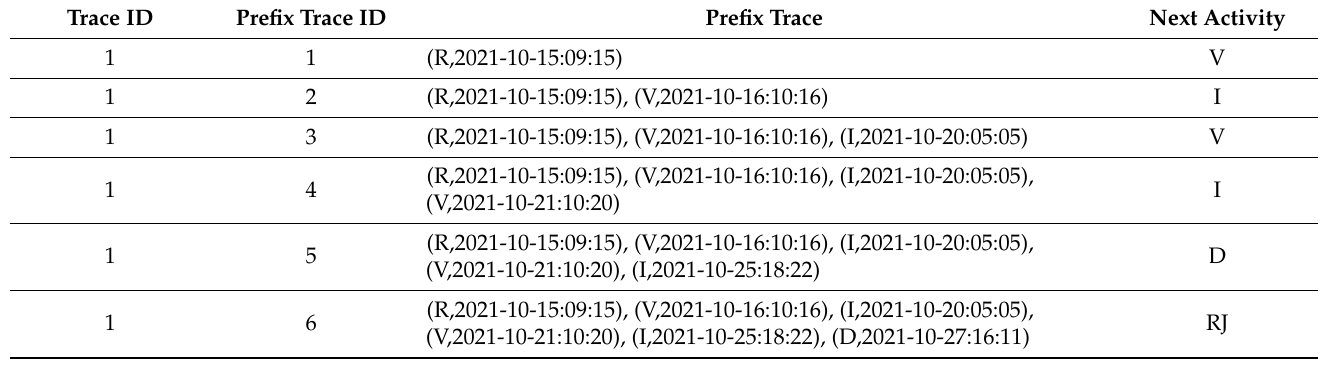
Table 1. Event log fragment with prefix trace and next activity.